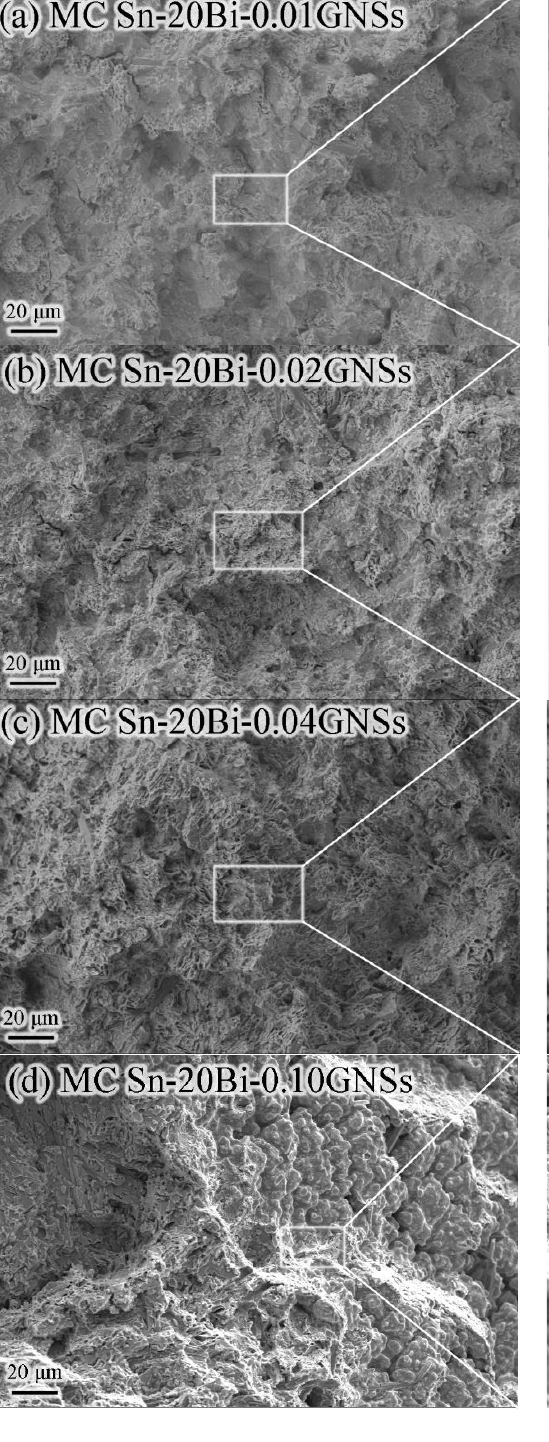
Figure 4. SEM images of the tensile fracture morphologies of MC Sn-20Bi- q GNSs alloys: ( a ) q = 0.01, ( b ) q =0.02, ( c ) q = 0.04, and ( d ) q = 0.10. ( b ) q =0.02, ( c ) q = 0.04, and ( d ) q =